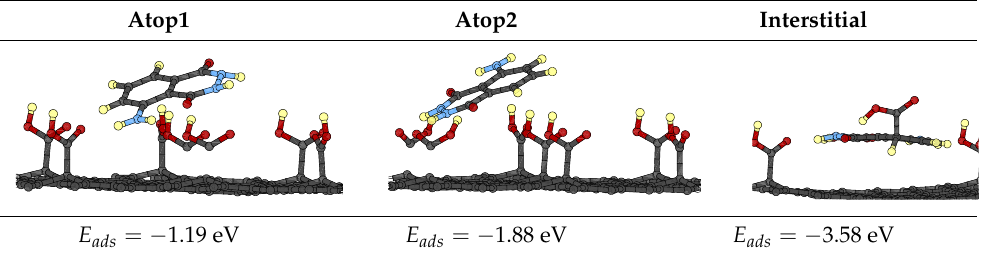
Table 1. A comparison of the adsorption energies of the three favourable adsorption sites for luminol on COOH-graphene. All three sites are more energetically favourable than luminol adsorption to bare graphene with E ads = − 0.97 eV. Atop1 Atop2 Interstitial